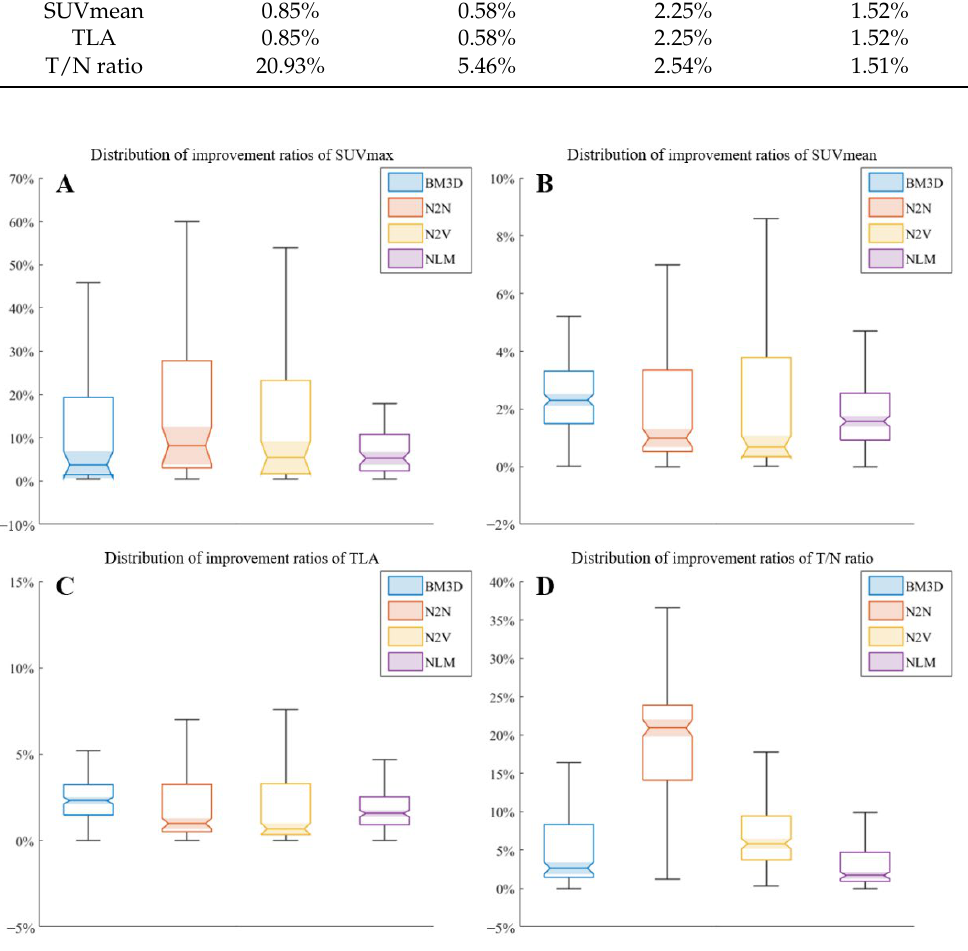
Figure 6. Distributions of the improvement ratios of SUVmax ( A ), SUVmean ( B ), TLA ( C ) and T/N ratio ( D ).